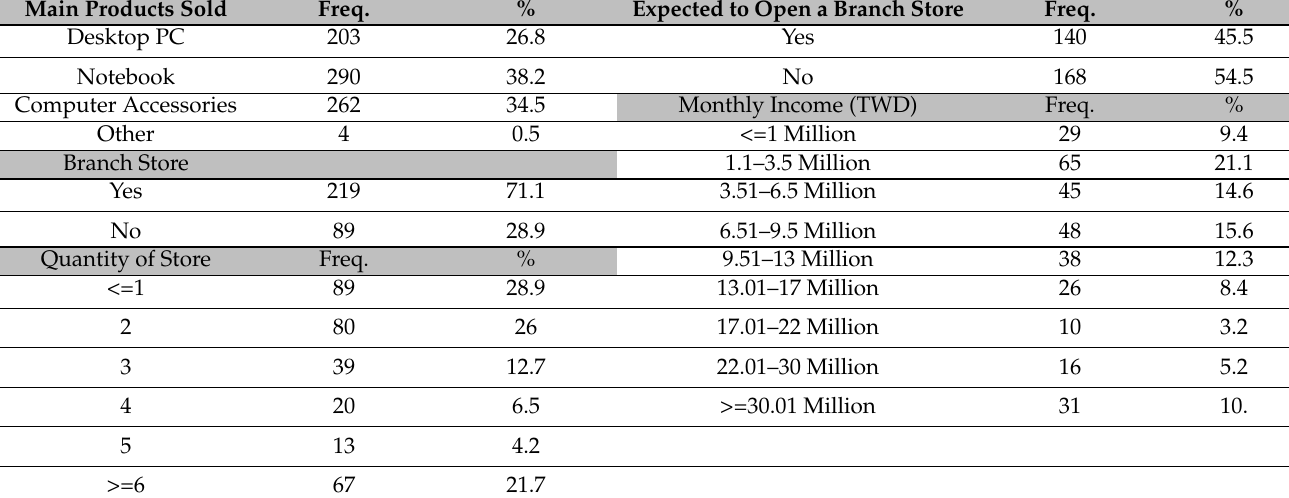
Table 3. Descriptive statistics of the respondents’ company